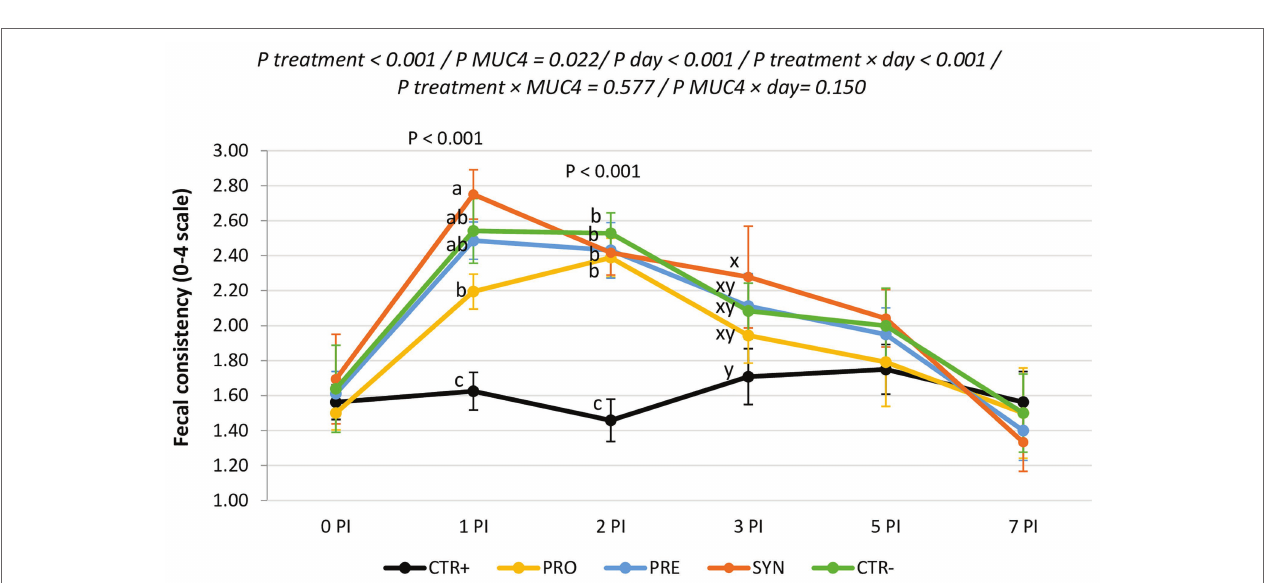
FIGURE 2 | Evolution of average fecal scores for the different experimental groups during the post-inoculation (PI) period. CTR+: non-inoculated animals receiving placebo; PRO − : inoculated animals receiving the probiotics; PRE − : inoculated animals receiving the prebiotic; SYN − : inoculated animals receiving the synbiotic; CTR − : inoculated animals receiving placebo. N = 6 for all groups except for non-challenged animals ( N = 8). MUC4 represents the effect of polymorphism of the MUC4 gene. a,b, and c indicate statistically significant differences between groups. x and y indicate statistical trends among groups. Bars correspond to the standard error. PI,